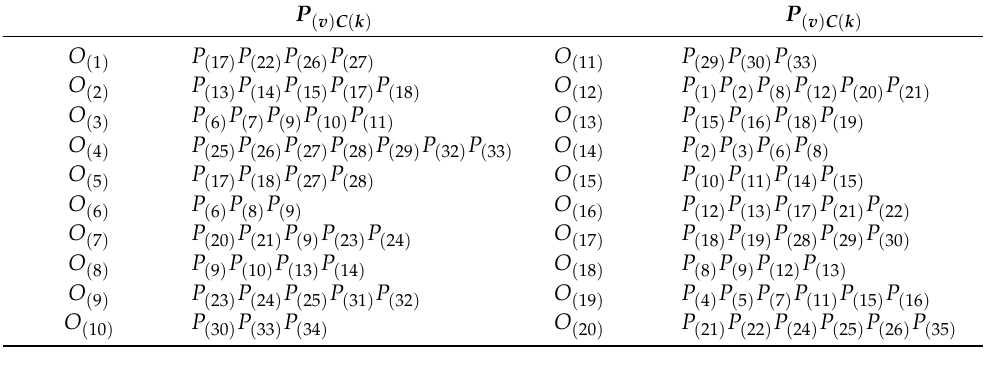
Table 2. The Closed list C l ( i ) , which stores the structural location point P ( v ) C ( k ) of the unit C ( k ) with the cellular core O ( k ) m .